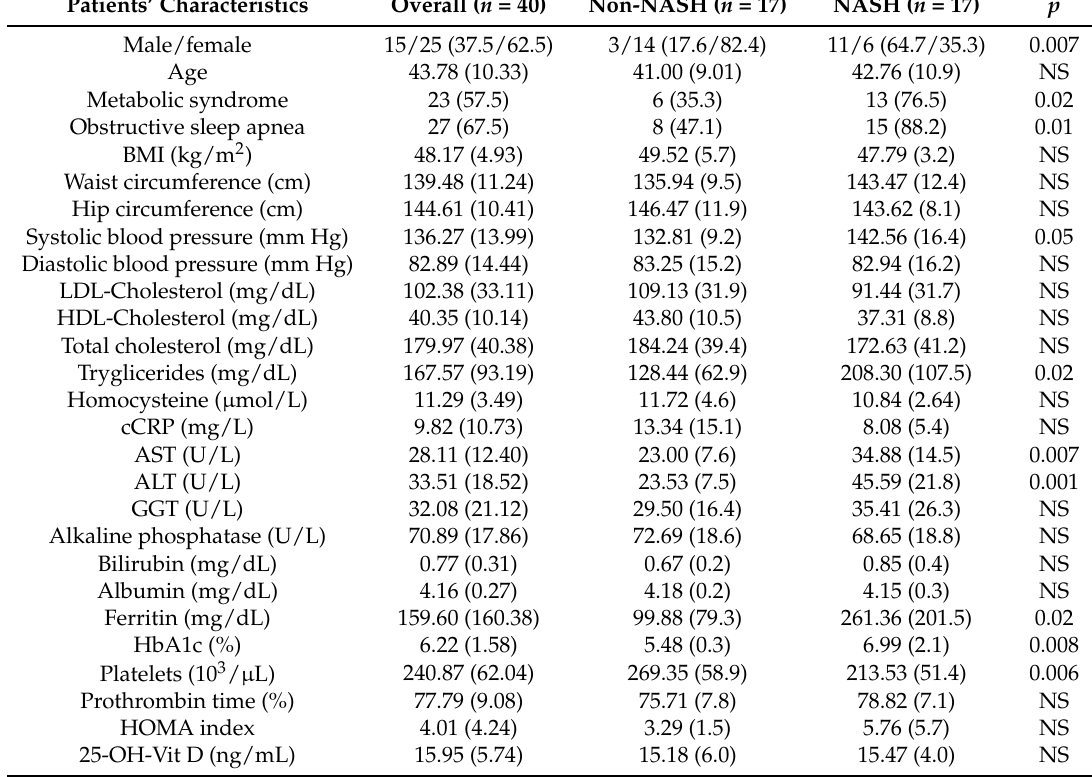
Table 1. Clinical, anthropometrical and analytical data of the study population. Comparison of patients’ characteristics according to the presence of non-alcoholic steatohepatitis in liver biopsy. Patients are clustered according to histology: non-alcoholic steatohepatitis (NASH) group includes possible and definite cases of steatohepatitis; NAFL group includes patients in which steatohepatitis has been ruled out. Qualitative data is presented as total number and percentage in brackets. Quantitative data is presented as mean and standard deviation in